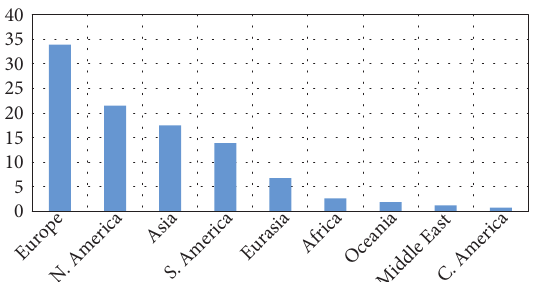
Figure 2: Percentage of world total RES installed power in 2006 – 2015, IRENA statistic